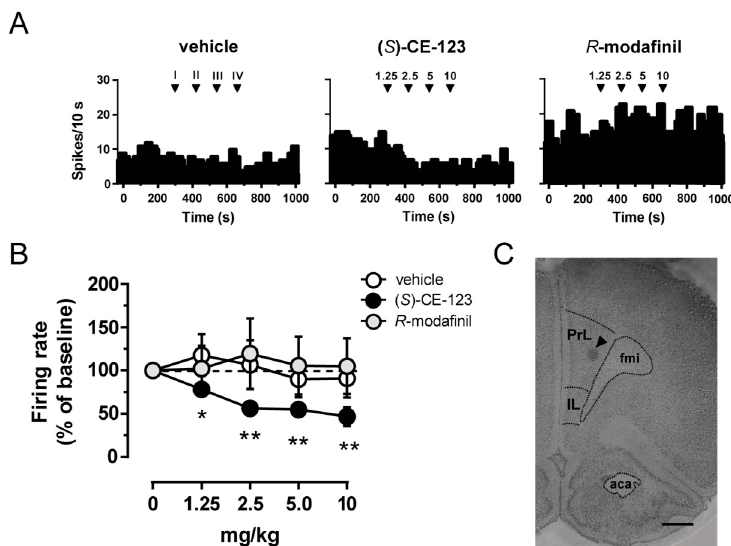
Figure 1. E ff ect of ( S )-CE-123 and R -modafinil on in vivo electrical activity of putative pyramidal cells. Representative firing rate histograms of putative pyramidal neurons ( A ) from rats that received cumulative intravenous injections of vehicle (left), ( S )-CE-123 (10 mg / kg; middle) or R -modafinil (10 mg / kg; right). Arrows indicate the time of injections and number of the dose (mg / kg). ( S )-CE-123 reduced firing frequency ( B ) in a dose-dependent manner (vehicle n = 5; R -modafinil n = 7, ( S )-CE-123 n = 7). Symbols and bars represent means ± SEM, * p < 0.05, ** p < 0.01, RM one-way ANOVA and Dunnett’s test. ( C ) Histological brain section showing the recording site in the prelimbic / infralimbic cortex. The black triangle indicates the pontamine sky blue dye. Abbreviations: PrL, prelimbic cortex; IL, infralimbic cortex; aca, anterior commissure, anterior part; fmi, forceps minor of the corpus callosum. Scale bar 1 mm.